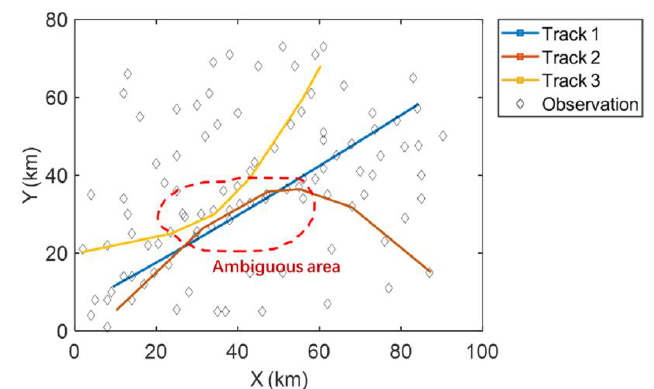
Figure 13. The tracking results of the EnKF for three targets without MHT.